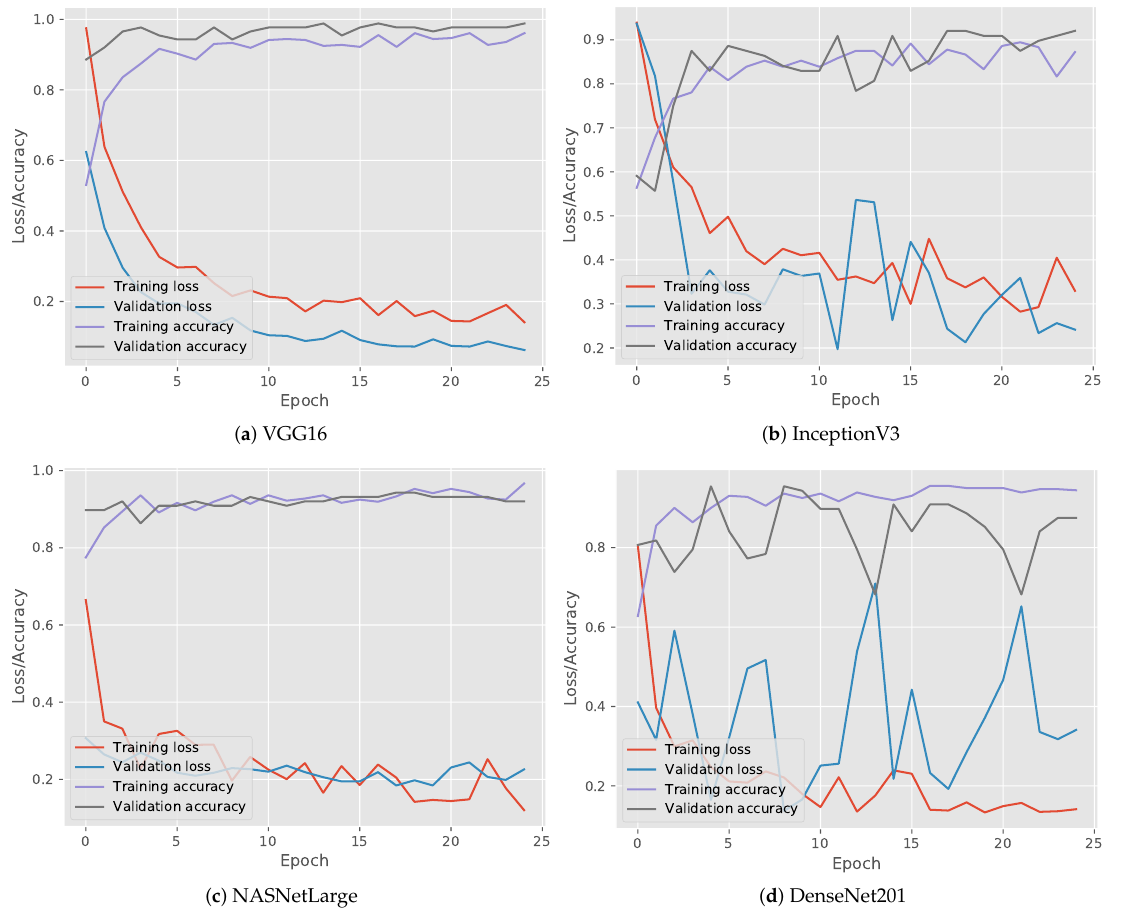
Figure 13. Accuracy and loss (train and test) of deep learning models for Pattern A. Additionally, we compared our results with other methodologies for trajectory classifi- cation, which were illustrated in the recent survey of Wang et al. [5]. Well-known classifiers such as Random Forests (RFs) and Support Vector Machines (SVMs) are employed by state-of-the-art methodologies for trajectory classification, on features extracted from the AIS messages or data points of the trajectories. Thus, three features from the trajectories during each type of activity (anchored, moored, and underway) were extracted: (i) the average speed of the vessel, (ii) the standard deviation of its speed, and (iii) the haversine distance between the first and the last vessel position. These features were selected because they demonstrated distinct differences between these specific activities. A moored